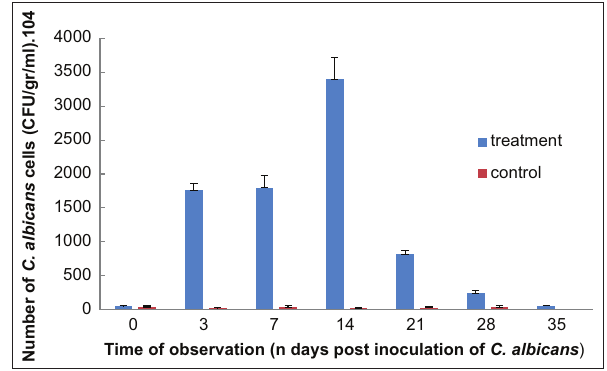
Figure-1: The density of Candida albicans in the